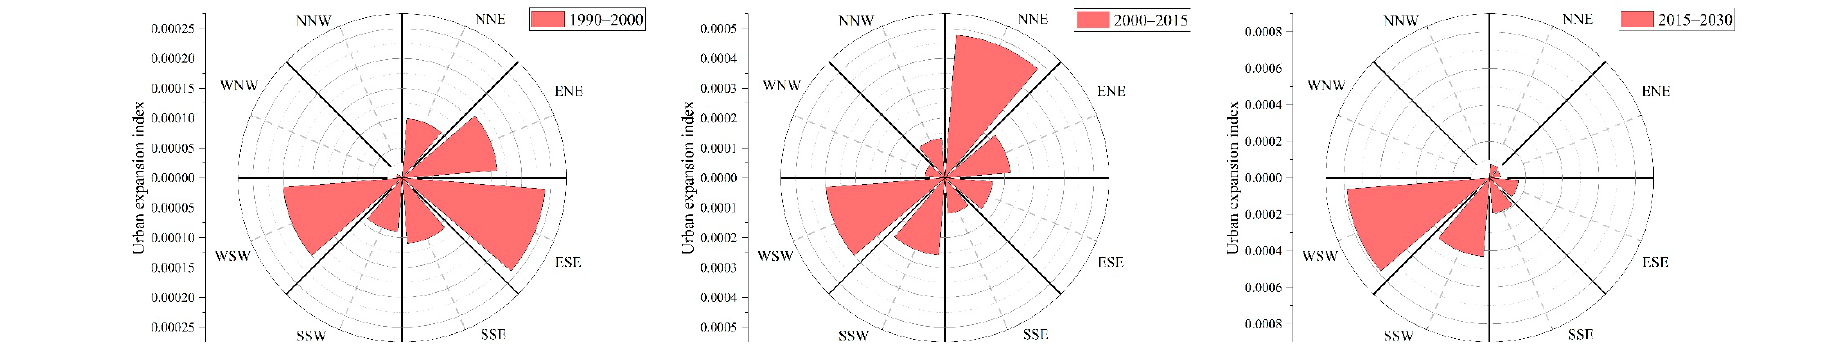
Figure 9. Urban expansion index during the different periods.